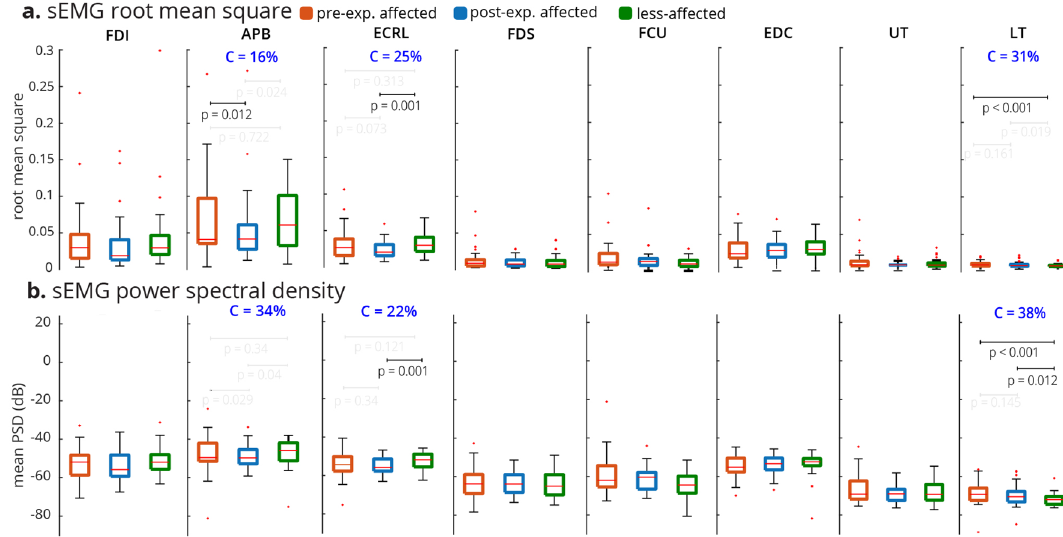
Figure 2. RMS and PSD of sEMG across n = 32 subjects. ( a ) For each electrode, the median RMS of sEMG envelope is quantified across all trials, and conditions per subject. Differences in the RMS values were only significant for the APB, ECRL, and LT muscles based on the Friedman test. The conformity ratio (the percentage of the subjects that followed the median group trend) for the significant comparisons was C < 31%. ( b ) For each electrode, the median of mean-PSD is quantified across all trials and conditions per subject. The differences in PSD were significant for the APB, ECRL, and LT muscles based on the Friedman test. The conformity ratio for the significant comparisons was C <